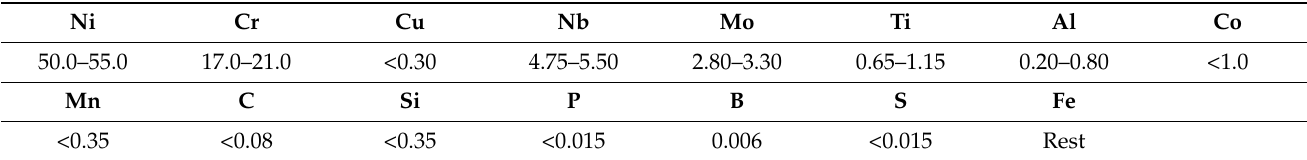
Table 1. Chemical composition of Inconel 718